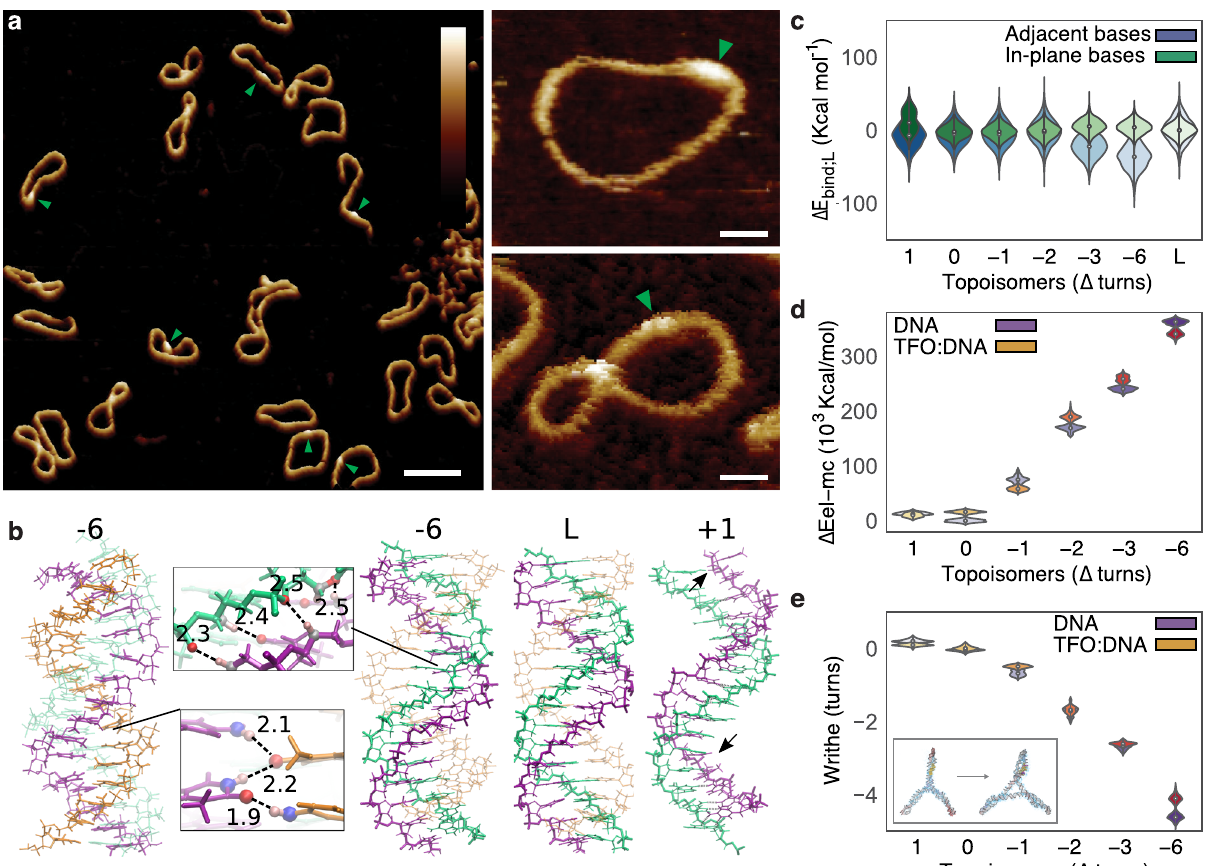
Fig. 4 Conformational diversity in supercoiled DNA minicircles contributes to the triplex formation. a AFM images showing triplex formation across a range of DNA minicircle conformations. Triplex regions are visible as small, sub-nanometre protrusions from the DNA marked by green arrowheads. Height scales (scale bar inset): 3 nm and scale bars: (single minicircles) 10 nm and (population): 50 nm. b Representative structures of DNA triplex from − 6 and + 1 topoisomer simulations compared to linear DNA. Arrows indicate less favourable Hoogsteen hydrogen bonds in positively supercoiled DNA. The WC-pyrimidine strand is erased from Δ Lk = + 1 image for visualisation purposes. c Violin plot of non-bonded interactions for the triplex-binding site ( Δ E bind;L ), showing the relative contributions from in-plane base interactions (e.g. WC and Hoogsteen hydrogen bonds) (green), compared to interactions between adjacent bases (e.g. bifurcated and backbone hydrogen bonds and stacking energies) (blue). d Violin plot for electrostatics of the whole minicircle ( Δ E elec;0 ) with (orange) and without (purple) TFO bound. e Minicircle writhe for modelled topoisomers with (orange) and without (purple) TFO bound. Inset shows a half helical turn reduction in writhe on triplex binding for the Δ Lk = − 6